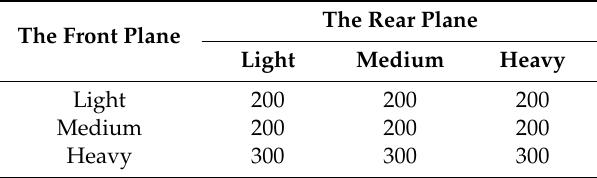
Table 1. Vortex separation Standards for aircrafts on airport surfaces (m).